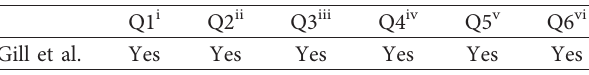
Figure 2: (a) Computed tomography (CT) of the abdomen demonstrating migration of self-expanding metal stent (SEMS) into the stomach (blue arrow). (b) Endoscopic appearance of distal esophagus demonstrating ulcer healing but with residual diffuse radiation Table 1: Methodological appraisal of the reported case using the Murad tool [18] for risk of bias assessment of case reports and case series.